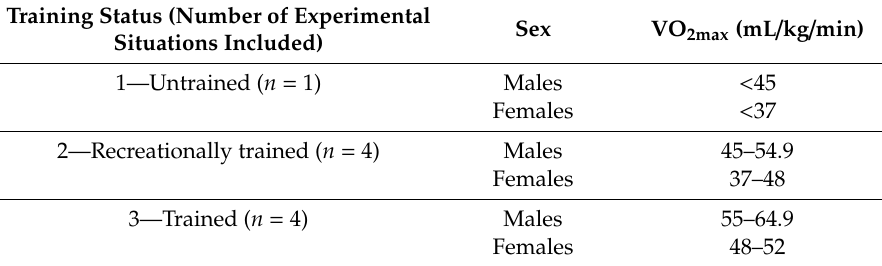
Table 1. Participant training status classification defined by VO 2max .